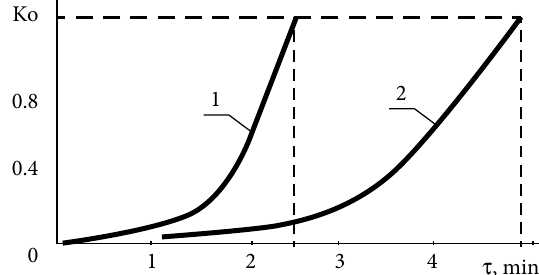
Fig. 2. Changing coefficient K0 when testing decorative finishing materials on a large-scale test bench: 1, IL-18,